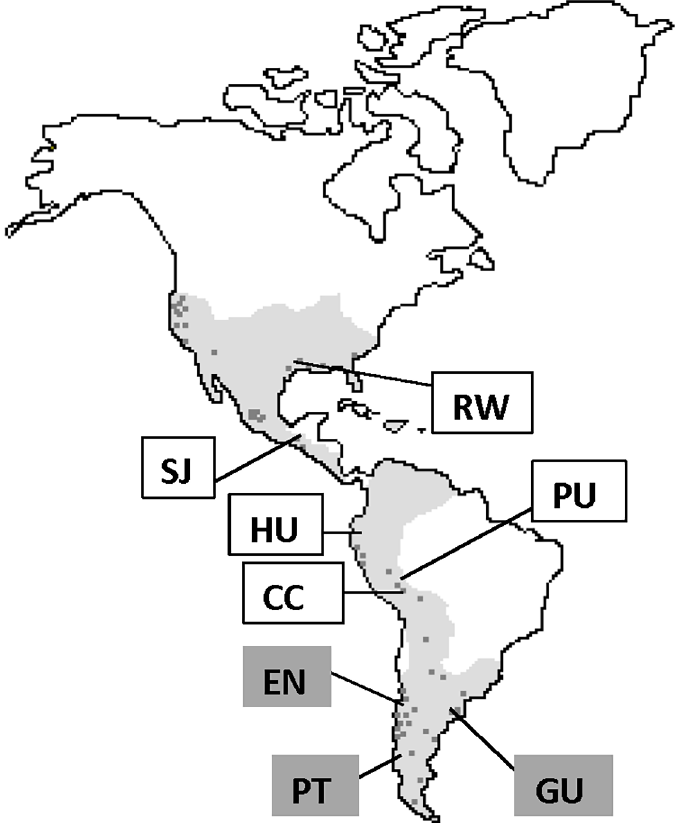
Fig 1. Geographic origins of the clones used in the cultivation experiment. The distribution of Schoenoplectus californicus in the Americas is shown in grey, the dots indicate the sampling locations [23]. The clones included in this study are indicated by letters: Variety tereticulmis EN: Ensenada, Chile; GU: Guillermo, Argentina; PT: Puente, Chile. Variety californicus CC: Copacabana, Bolivia; PU: Puno, Peru´; HU: Huanchaco, Peru´; SJ: San Juan, Guatemala; RW: Rockefeller, Louisiana.